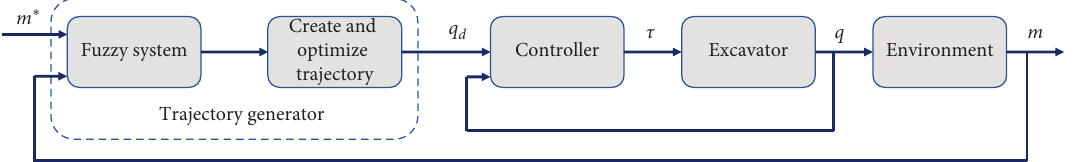
Figure 4: Whole system’s